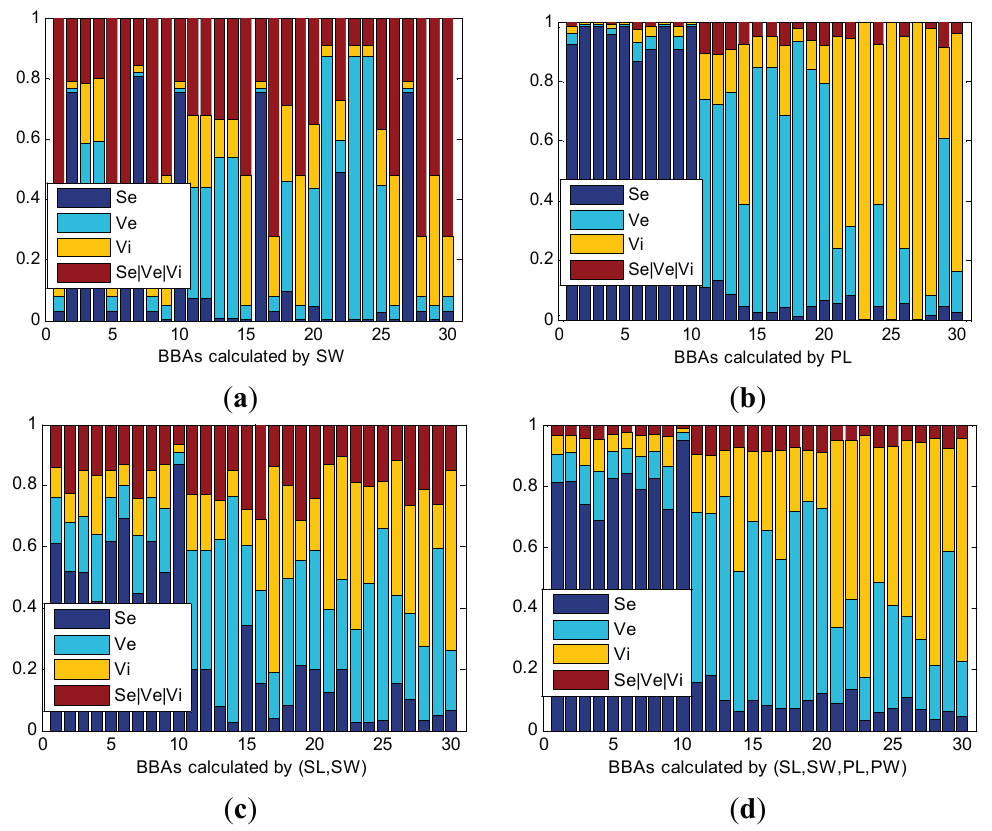
Figure 3. Partial BBAs calculate by the Eu-function includes ( a ): training set